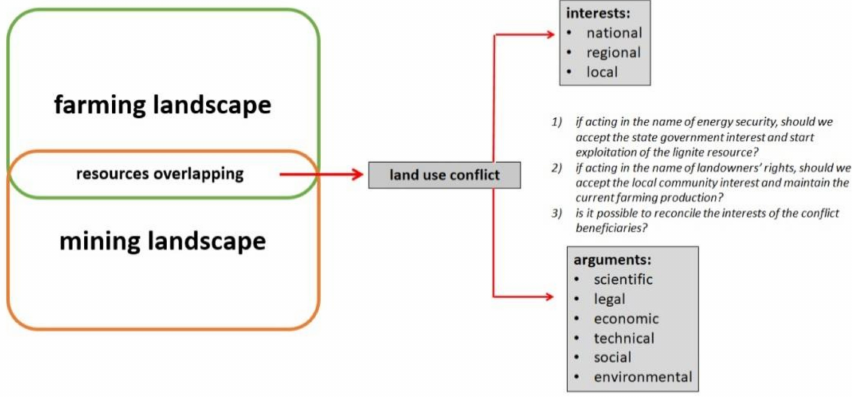
Figure 1. The methodological context of